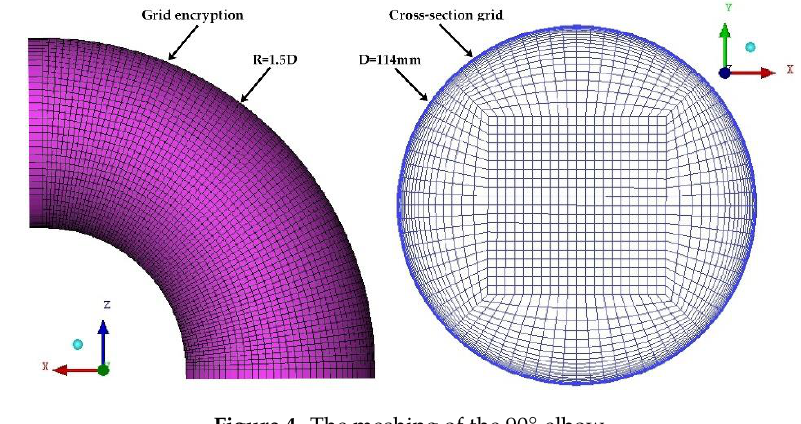
Figure 4. The meshing of the 90° elbow.